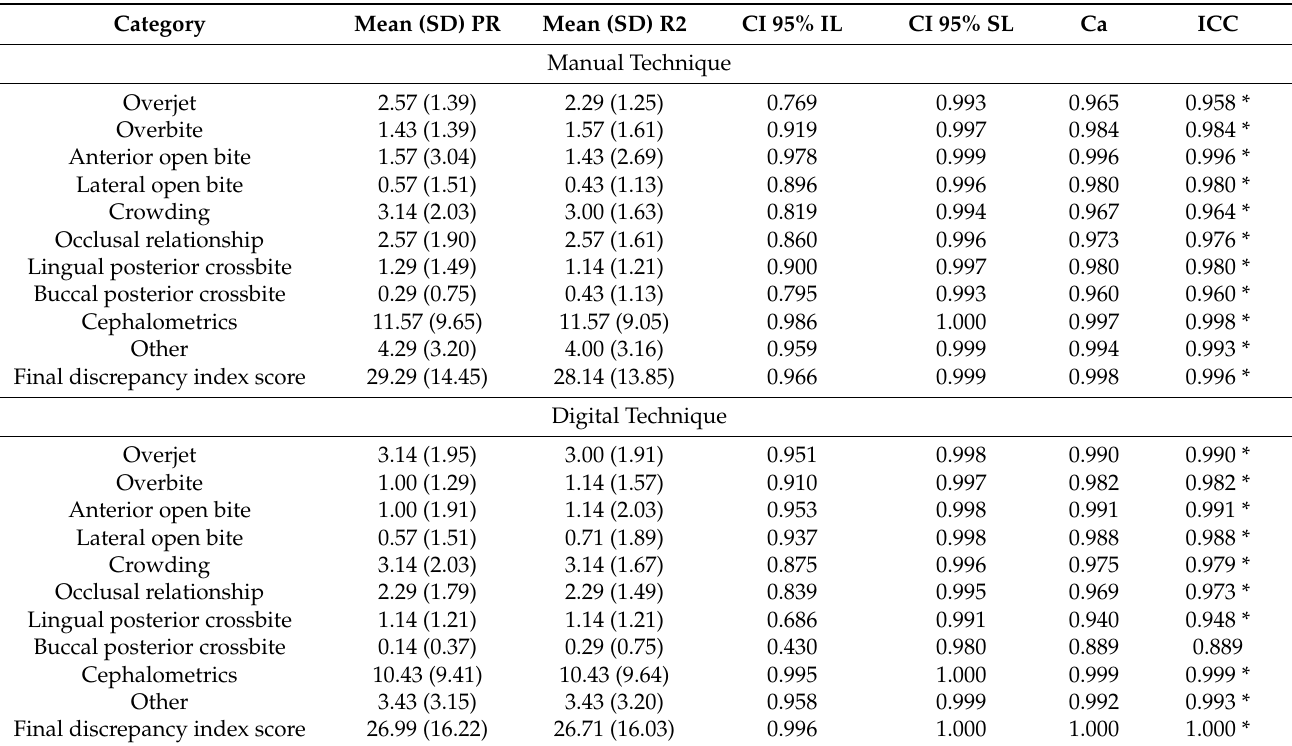
Table 3. Interrater reliability test.